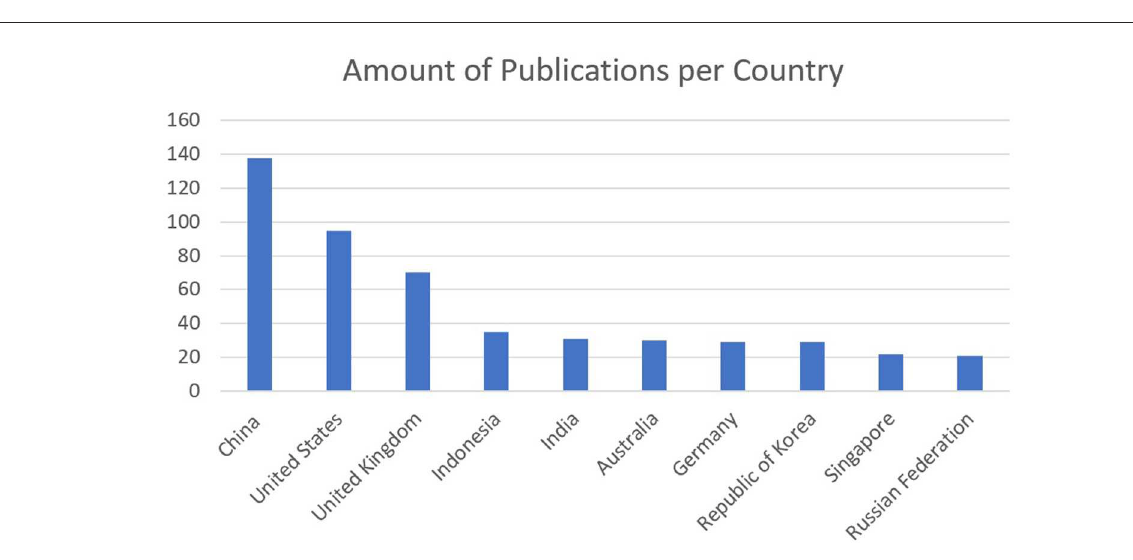
FIGURE3 Geographical distribution of scholarly literature on SME financial digitalization, number of publications. Source: The